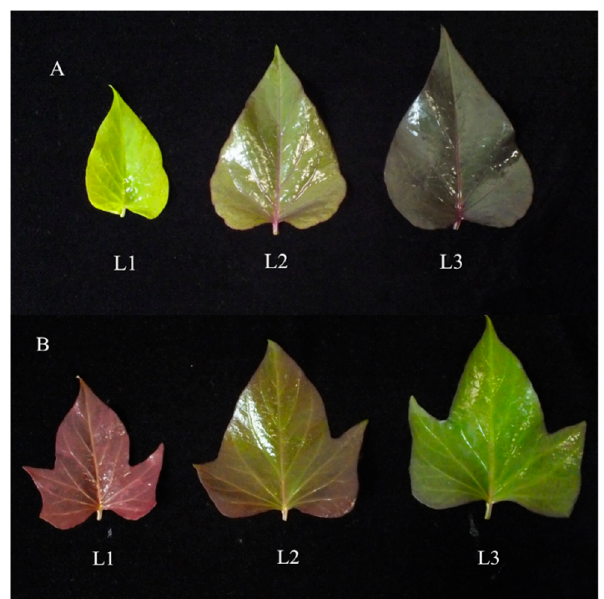
Figure 1. Photographs of sweet potato leaves with differential levels of accumulated anthocyanins. ( A ) Fushu No. 23, ( B ) Fushu No. 317, “L1” indicates the primary leaves (three days old), “L2” indicates the second leaves (five days old), and “L3” indicates the third leaves (seven days old).